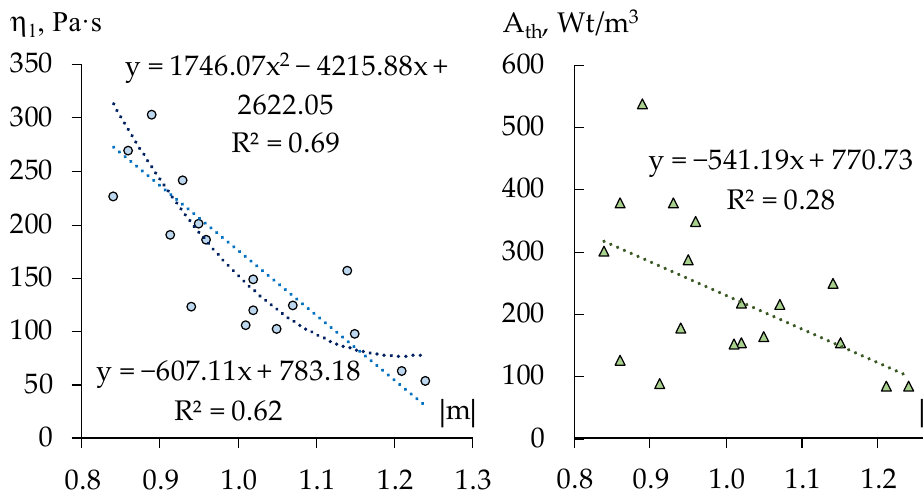
Figure 7. Scatter diagrams of viscosity at shear rate equal unity (K in Ostvald-de-Waele model), of thixotropy, and destruction rate of the 18 compositions (results of natural experiment).